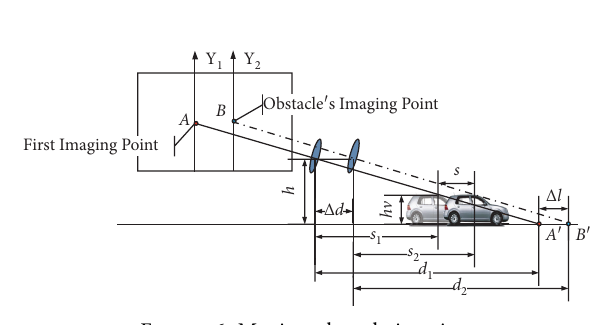
Figure 5: Static obstacle imaging.